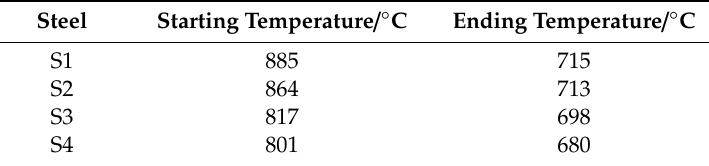
Table 2. Temperatures of austenite to ferrite transformation.